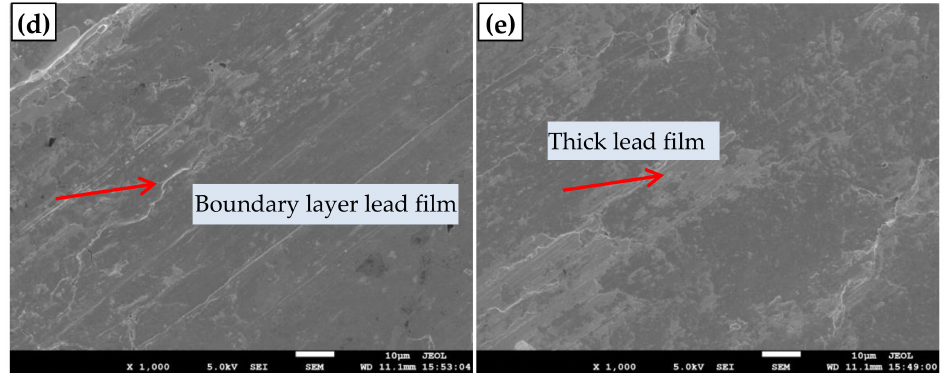
Figure 5. Analysis of friction topographies of ZCuPb 20 Sn 5 − x P; ( a ) P = 0.0 wt.%; ( b ) P = 0.05 wt.%; ( c ) P = 0.1 wt.%; ( d ) P = 0.2 wt.%; ( e ) P = 0.3